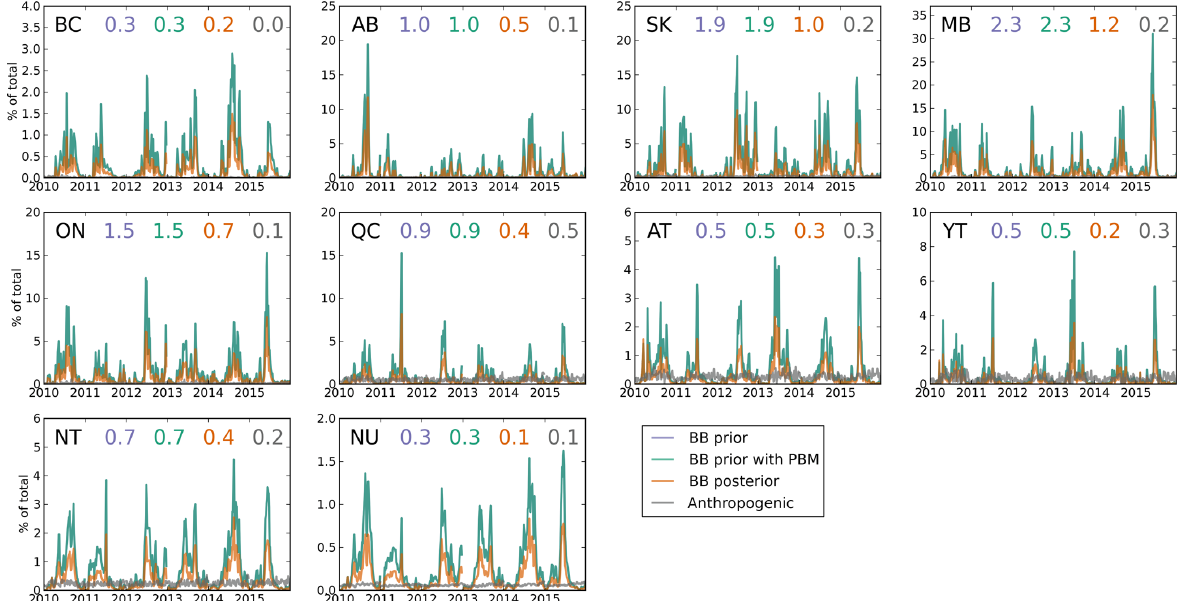
Figure 9. Percent contribution to total surface GEM concentration of Canadian biomass burning and anthropogenic emissions for burning seasons (May–September) of 2010–2015 for each province/territory. We have grouped the Atlantic provinces together as AT. Note the different y scales. Inset numbers are the mean percentage contribution to the total concentration over the 6